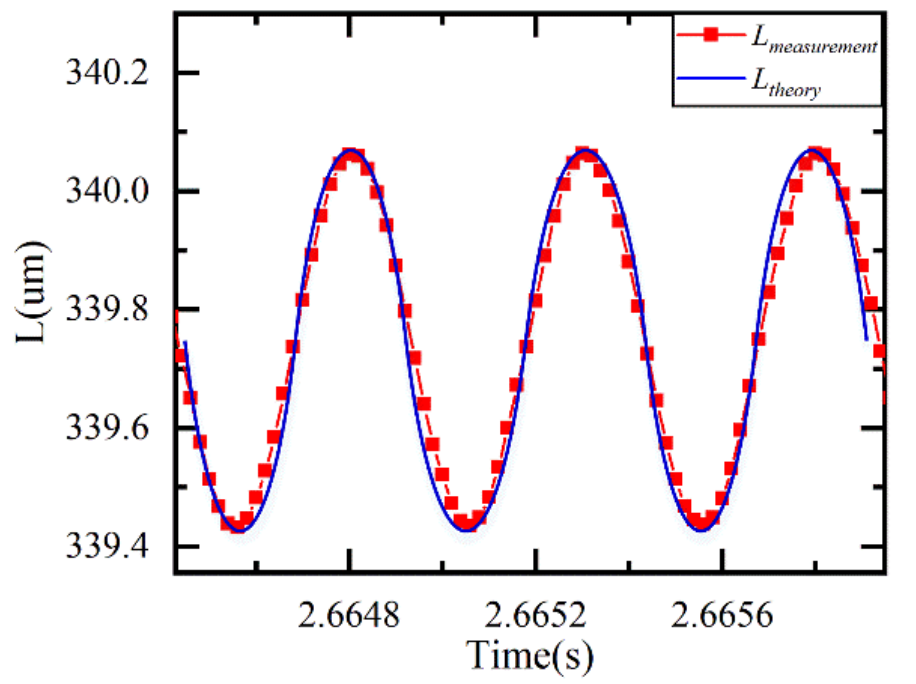
Figure 11. Dynamic real-time measurement results.